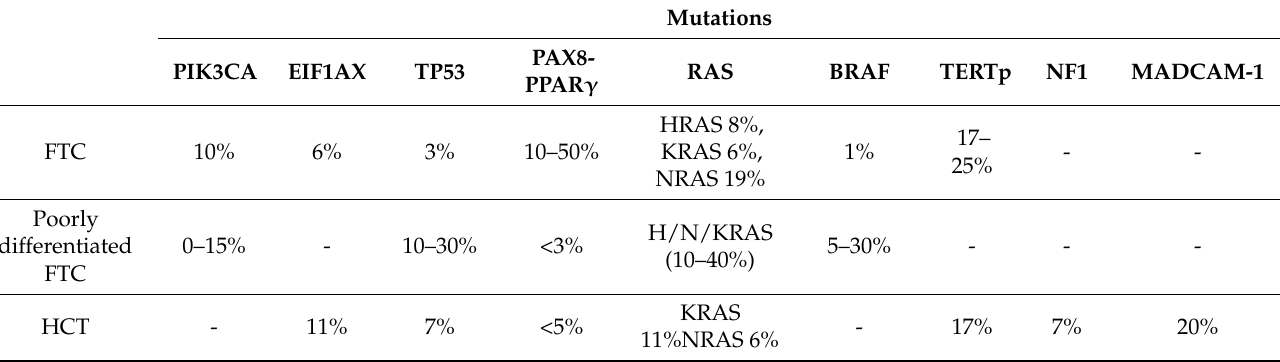
Table 2. Histological and molecular heterogeneity in FTC and